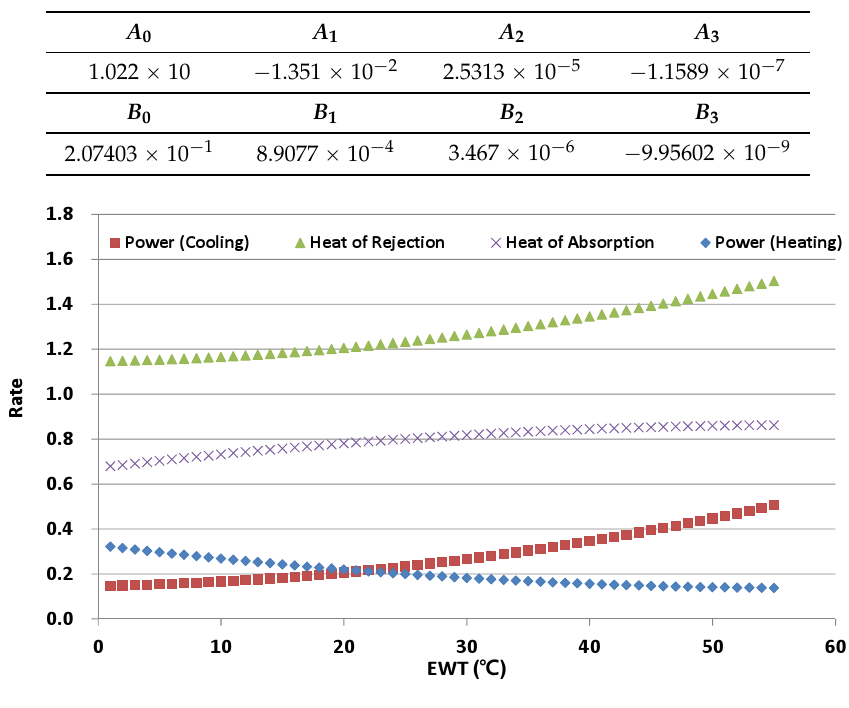
Table 1. Pump model coefficients for the single stage.